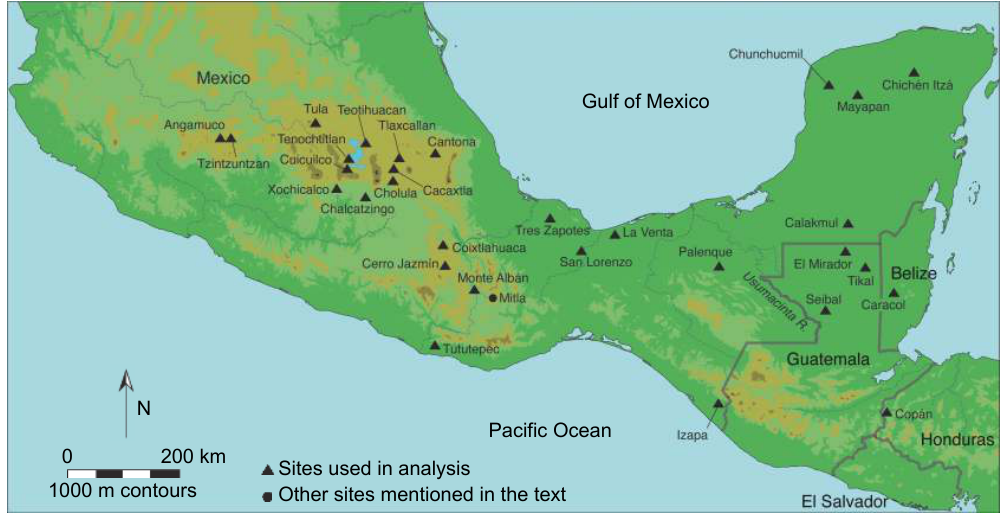
Fig. 2 Mesoamerica map with 30 central places in analytical sample and other sites